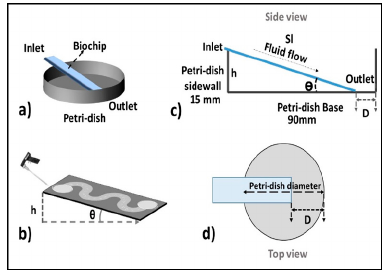
Figure 1. ( a , b ) Illustration of pipette Petri dish single-cell trapping (PP-SCT); ( c , d ) shows the side and top view, respectively, where θ is the tilt angle, h is the height of the inlet, D is the distance between biochip outlet side edge to the Petri dish wall along the diameter, and Sl is glass slide length.